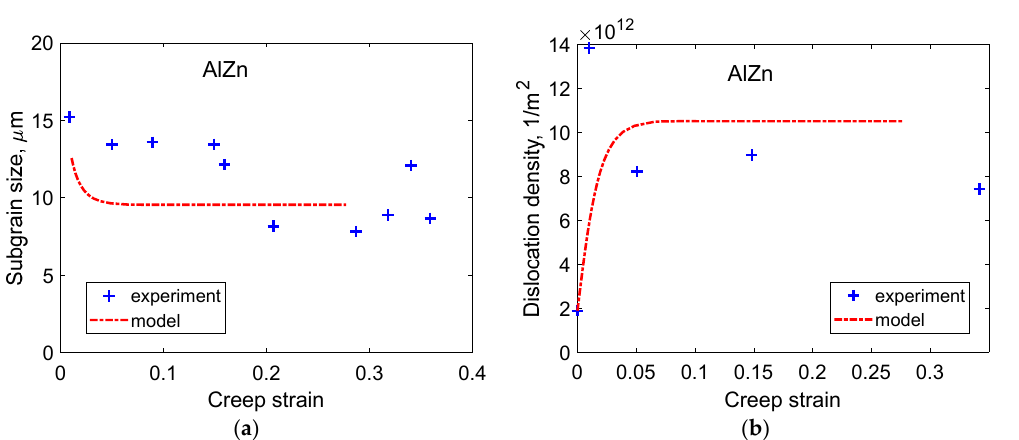
Figure 3. Subgrain size ( a ) and dislocation density ( b ) versus strain for Al5Zn at 250 °C and 16 MPa. Experimental data from [2,29].